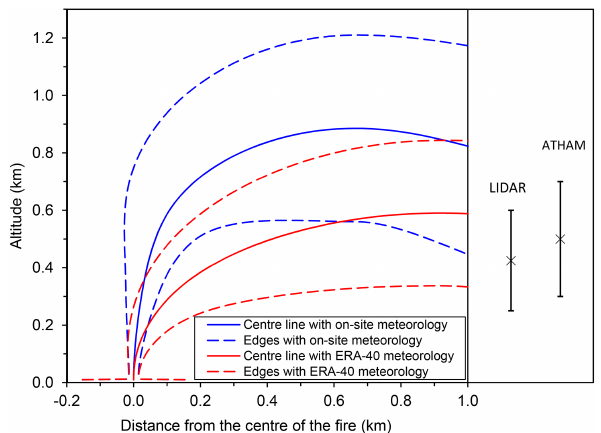
Figure 3. Simulated altitude of the centre line, and the lower and upper edges of the plume for the Quinault prescribed burn as a func- tion of the downwind distance. The results are shown both for using (i) the meteorological measurements made on-site (blue solid and dashed lines, denoted “on-site meteorology”) and (ii) the reanaly- sis of the meteorological observations (red solid and dashed lines, denoted “ERA-40 meteorology”). The vertical ranges of the pre- vious results obtained using on-site lidar measurements (“LIDAR”; Trentmann et al., 2002) and computations using the ATHAM model (Trentmann et al., 2002) have also been